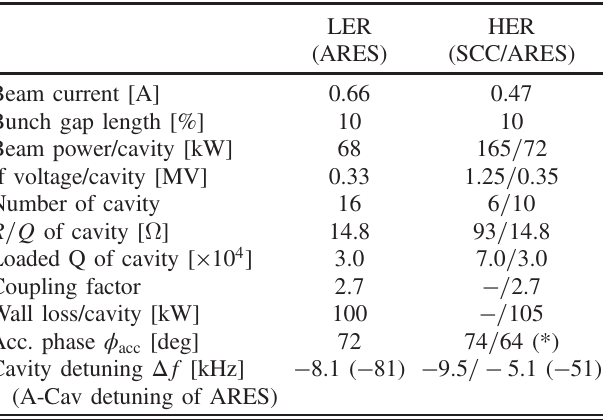
TABLE II. KEKB operation parameters used for the simulation of the observed condition.